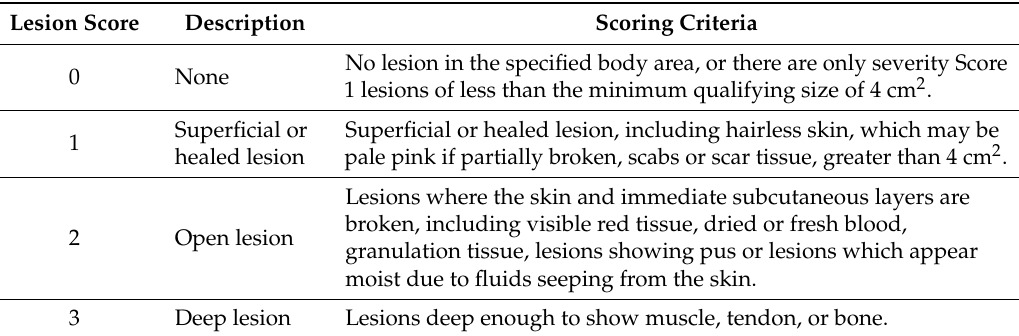
Table 2. Scoring criteria for lesions